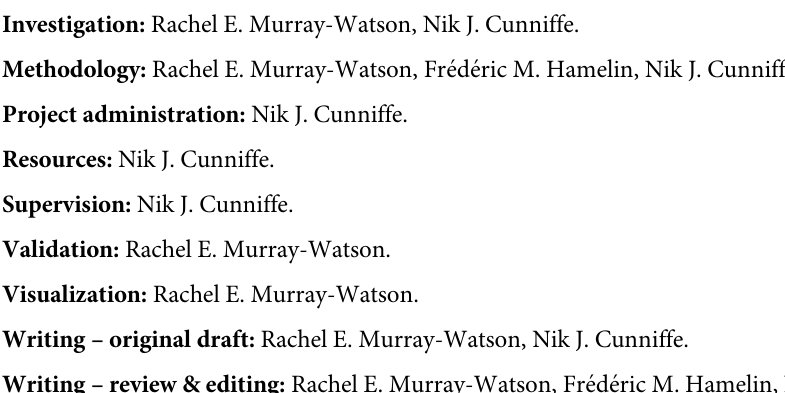
(Fig 2). Fig C: Effect of parameters on participation in the CSS. A—C shows results for the “strategy vs. population” and “strategy vs. alternative” model formulations; D—F are for the “grower vs. population” model. Parameters are as in Table 1 in the main text; the orange dia- monds mark the default values. A and D examine the impact of changing the cost of control ( ϕ ) and the rate of horizontal transmission ( β ). At low values of β , no-one should control as the probability of infection is sufficiently low that it is not necessary. As β increases, controlling is more beneficial and the cost of control is perceived to be worthwhile. However, as infection becomes more likely, the value of control diminishes so it is not worthwhile to invest in con- trol. In the “strategy vs.” comparisons, it is possible to reach an “all control” equilibrium, though this cannot happen for the “grower vs. population” model. B and C At very high proba- bilities of vertical transmission ( p ) and loss due to disease ( L ), growers will participate in the CSS, though only for a narrow range of β . However, for the “grower vs. population” models, a much wider range of all parameters allowed for participation. The irregular contours in E and F are due to oscillations around the equilibrium. Fig D: Effect of changes in the rate of sec- ondary transmission ( β ) and probability of vertical transmission ( p ) on the proportion of controllers when ϕ = 0.125. Compared to the default value of ϕ = 0.25, a higher proportion of growers control for a broader range of parameter